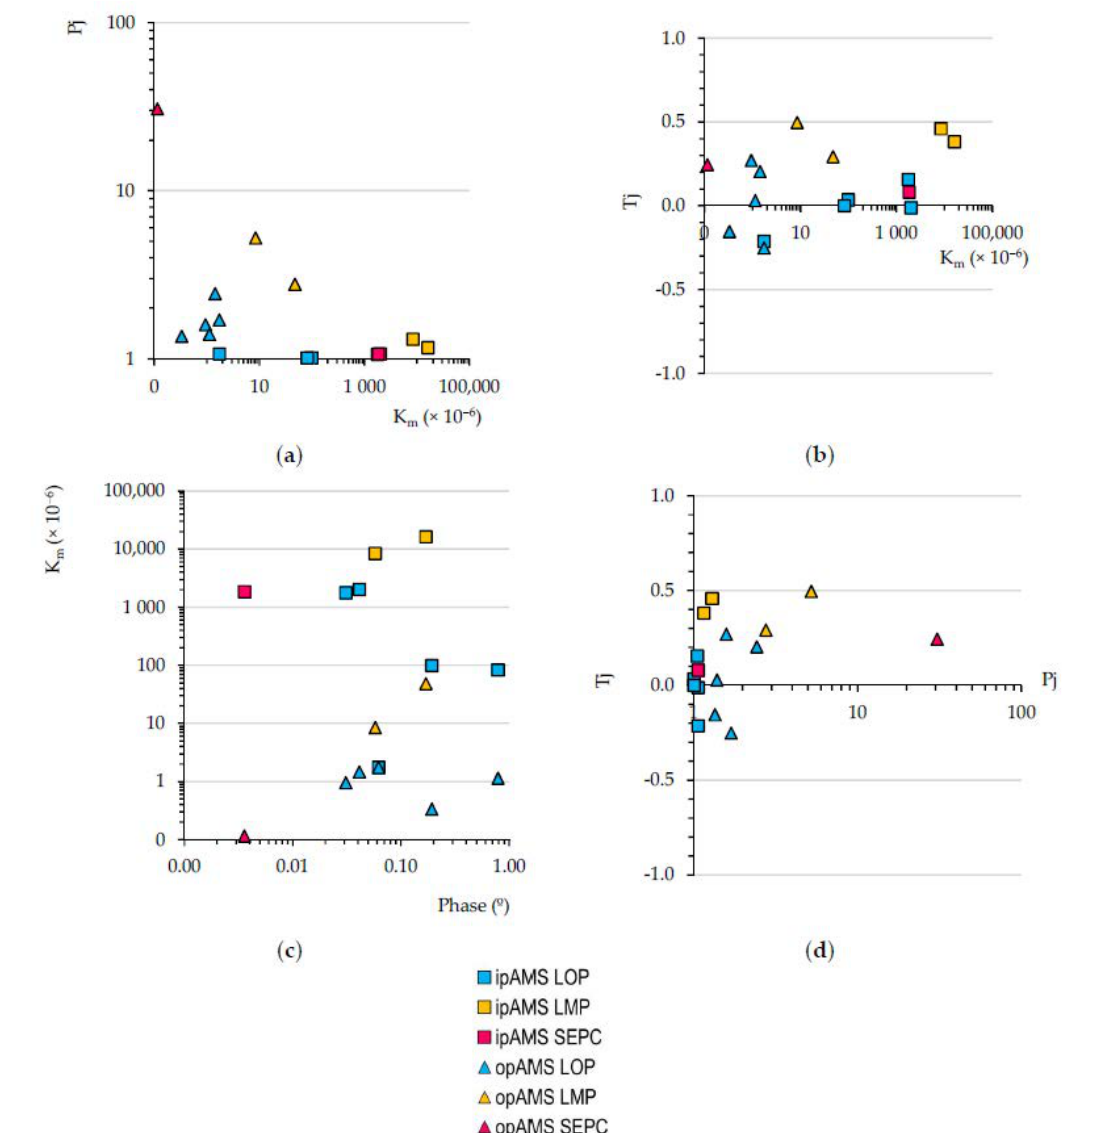
Figure 3. ( a ) P j vs. K m plot; ( b ) Tj vs. Pj plot; ( c ) T j vs. K m plot; ( d ) K m vs. phase angle (ipAMS—in- phase AMS; opAMS—out-of-phase AMS); LOP—Lamas de Olo pluton; LMP—Lavadores-Madalena pluton; SEPC—Santa Eul á lia Plutonic